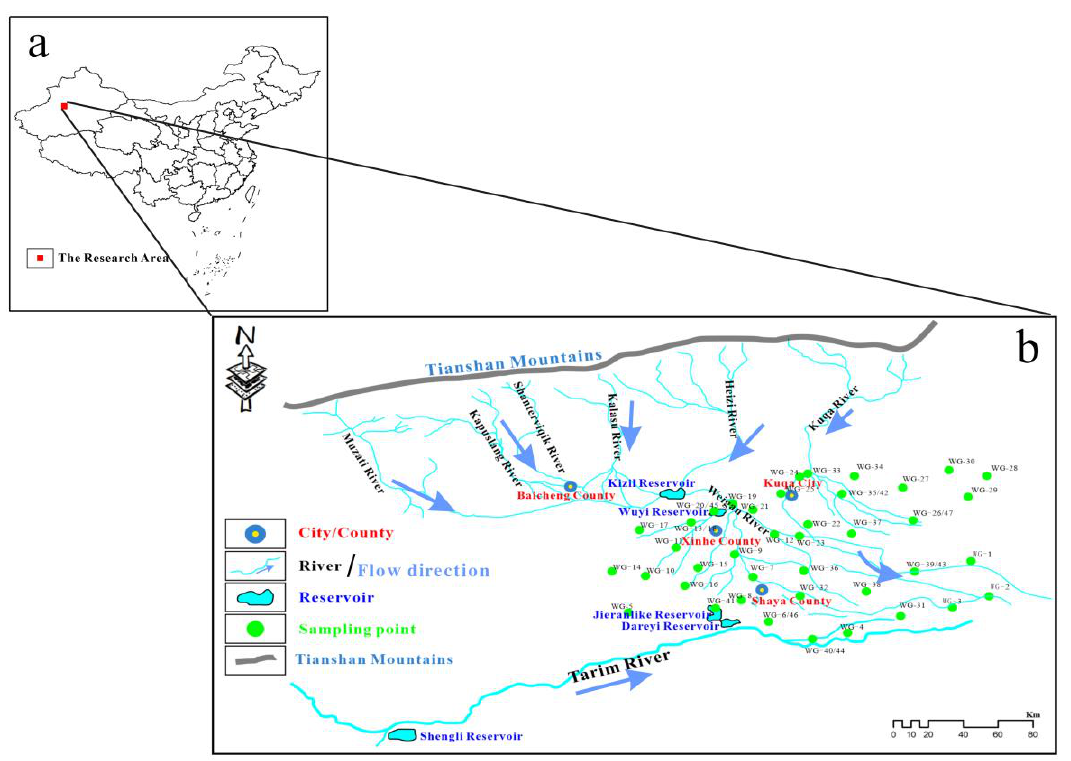
Figure 1. Overall geological and water system information of the research area and the sampling site distribution map. ( a ) Equivalent location map of the research area in China, ( b ) hydrological distribution and sampling point distribution map.